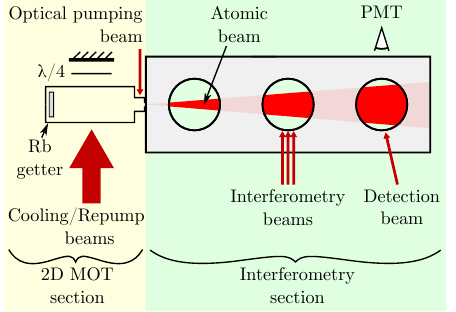
Figure 1. A schematic representation of our experimental setup. In the left (yellow) 2D-MOT section, a rubidium getter is used as an atomic source. Standard 2D-MOT cooling and repump beams with the correct circular polarization states are directed into the chamber and retroreflected through a quarter-waveplate. Another similar cooling beam (not depicted) travels vertically, into and out of the page. Prior to the 2D-MOT beam entering the interferometry section to the right (green) through a small aperture, an optical pumping beam is applied to optically pump the atoms to the dark state (or to shutter the atomic beam). The result is a diverging beam of cooled atoms traveling along the central axis of the science chamber, through the interferometry region from left to right. In this interferometry section, we have three areas of optical access where we apply the interferometry beams and implement our detection